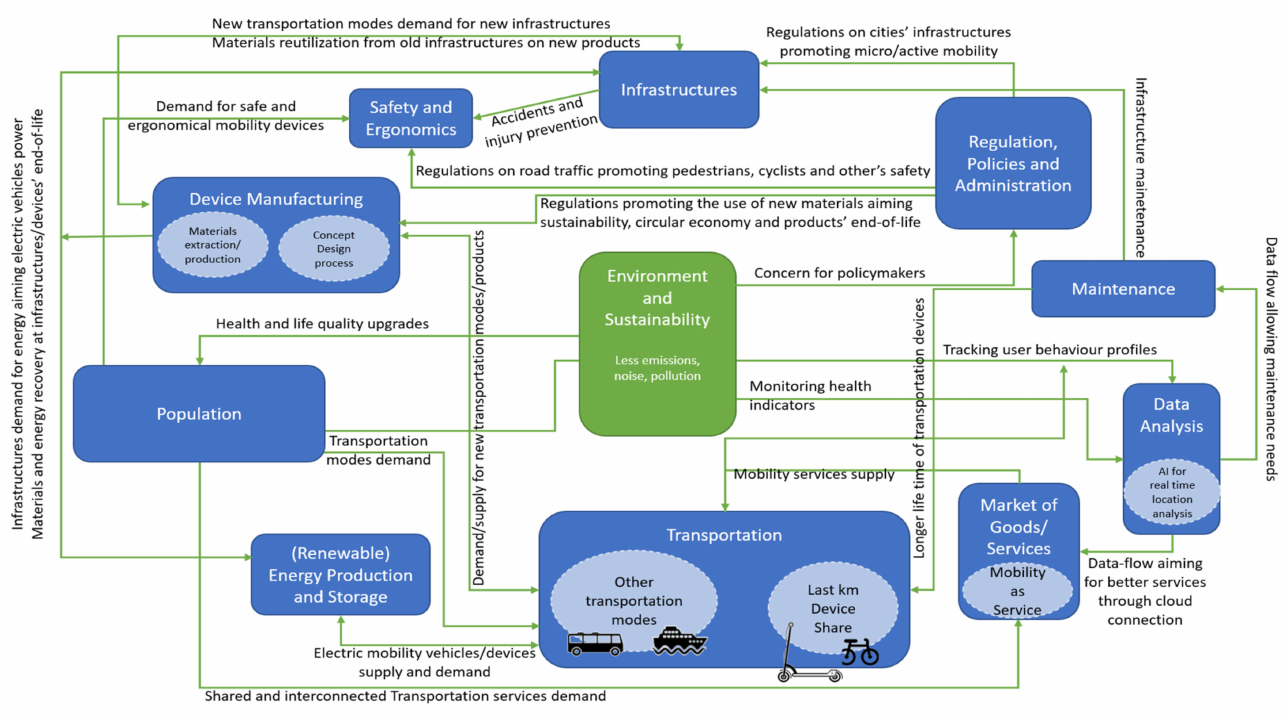
Figure 6. A framework of comprehensive integration through an LCT approach applied to micromo- bility